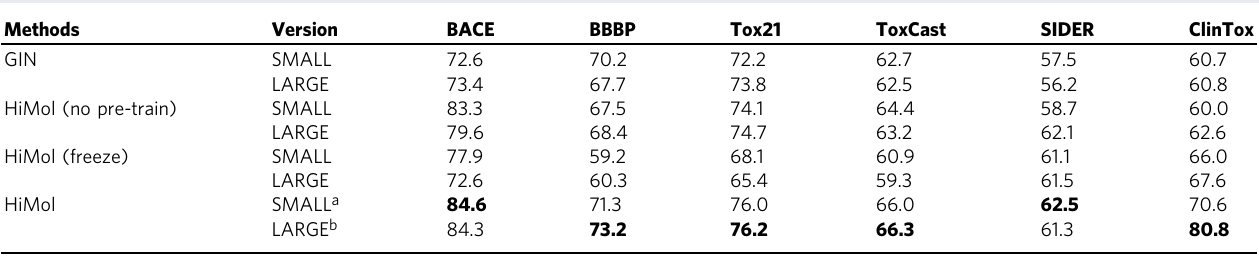
Fig. 3 Visualization of the top- fi ve molecules ranked by molecular representation similarity for the query ZINC9452931. SMILES for all molecules are given. Table 3 Classi fi cation performance of different fi ne-tuning